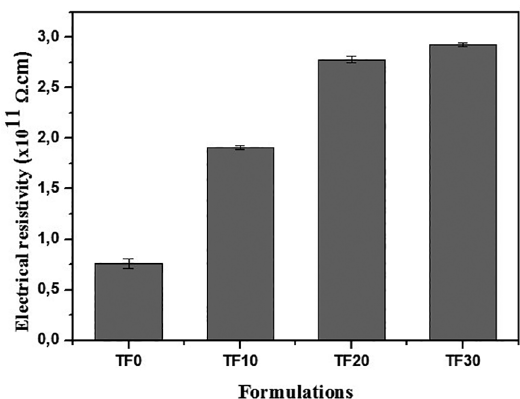
Figure 7. Electrical resistivity of the fired aluminous porcelain pieces.